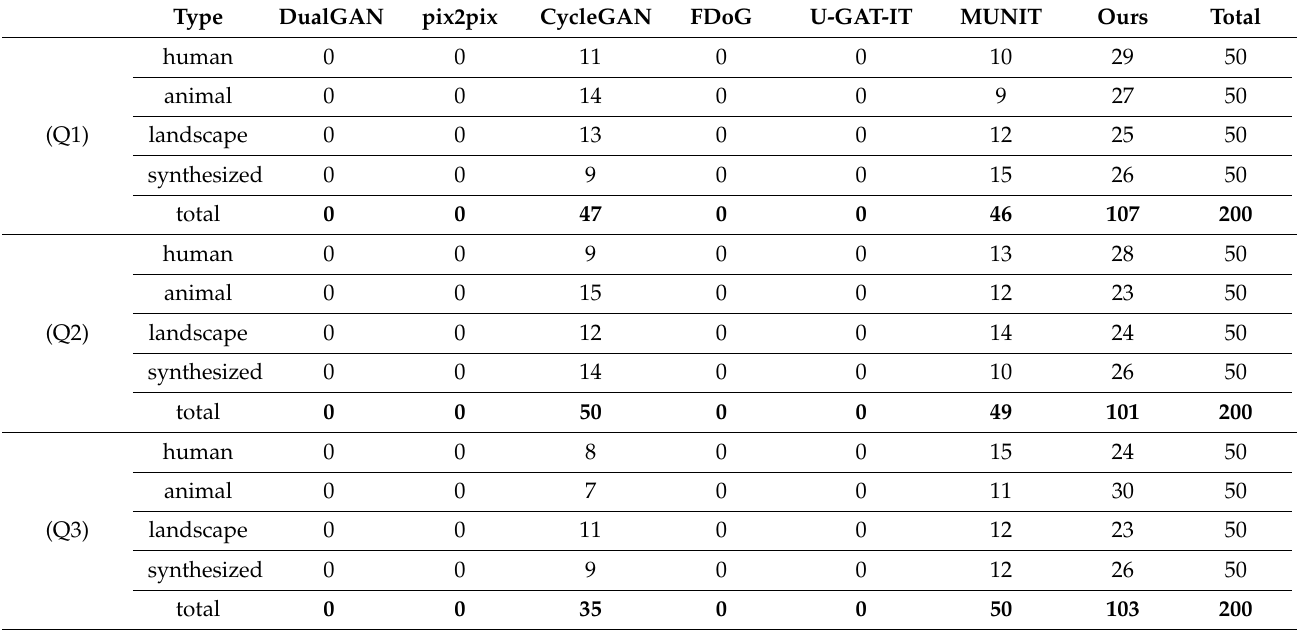
Table 4. The results of user